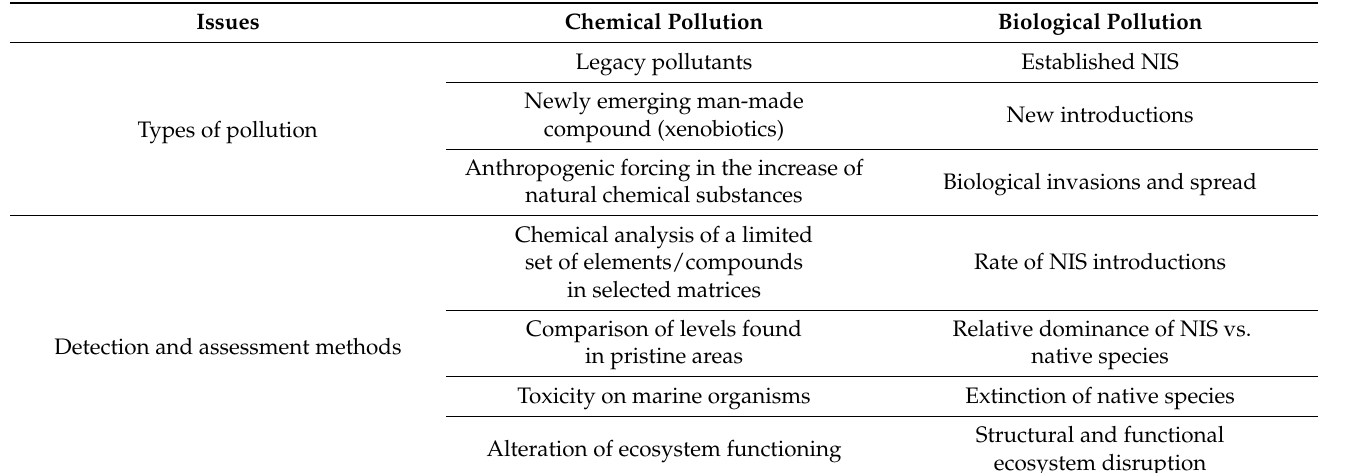
Table 2. Comparison of the chemical and biological pollution